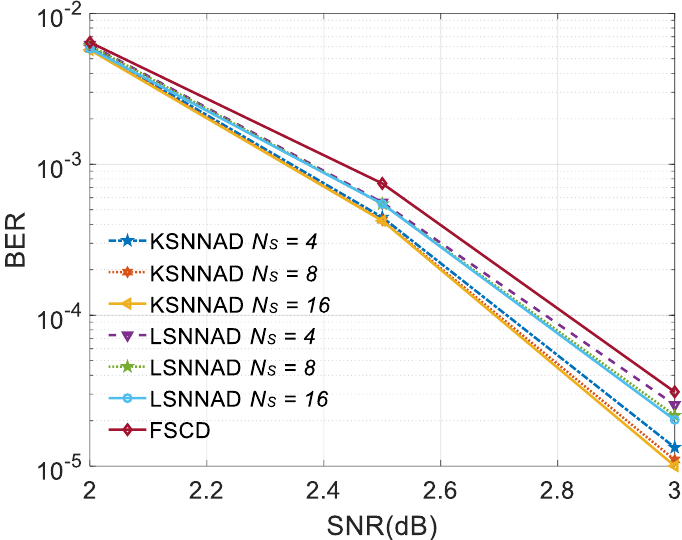
Figure 13. Decoding results of different N S